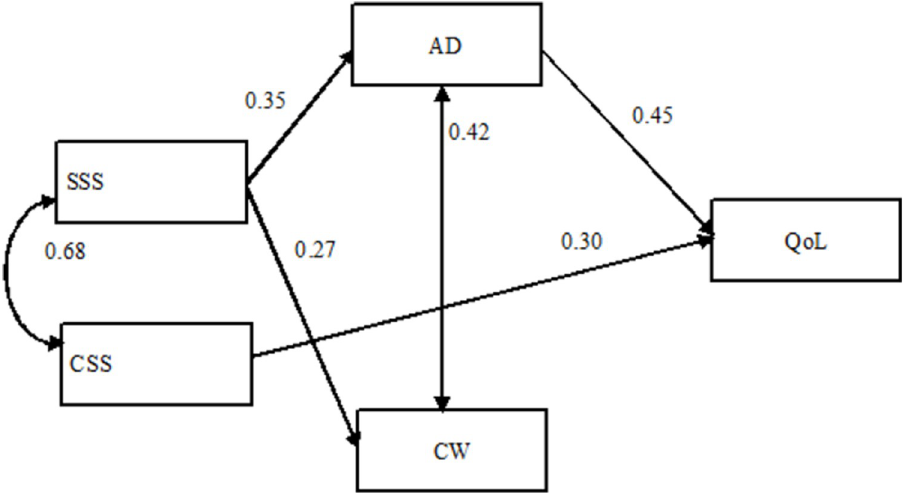
Fig 1. Path model depicting direct and indirect association between social support, presenteeism and quality of life. Values on single-headed arrows are standardized regression coefficients; values on the double-headed arrow are correlation coefficients. All paths are significant (p <